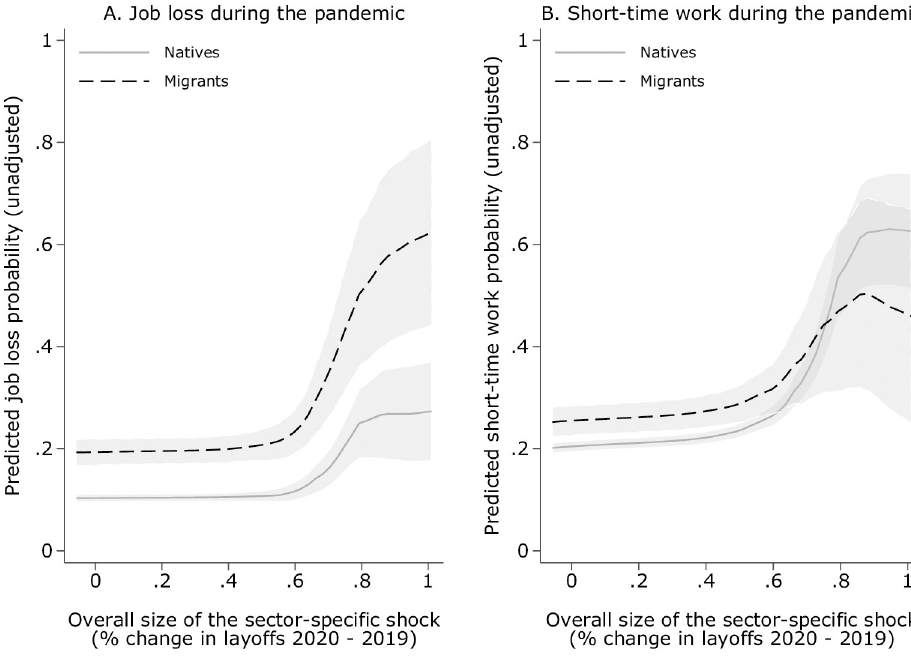
Fig 3. Raw difference between migrant and native layoffs. Note: Fig compares unadjusted layoff and short-time work propensity as reported by survey respondents with a migration background and without by the magnitude of the industry-specific economic shock (measured by the difference in newly unemployed between 2020 and the reference month in 2019). Local polynomial regression (bw = 0.2). Strongest cumulative change observed in service industry (+101% unemployed compared to 2019). S1 Fig shows the corresponding trends for the restricted sample of respondents surveyed in April and May (onset and peak of the shock). Source: Federal Employment Agency [3], own